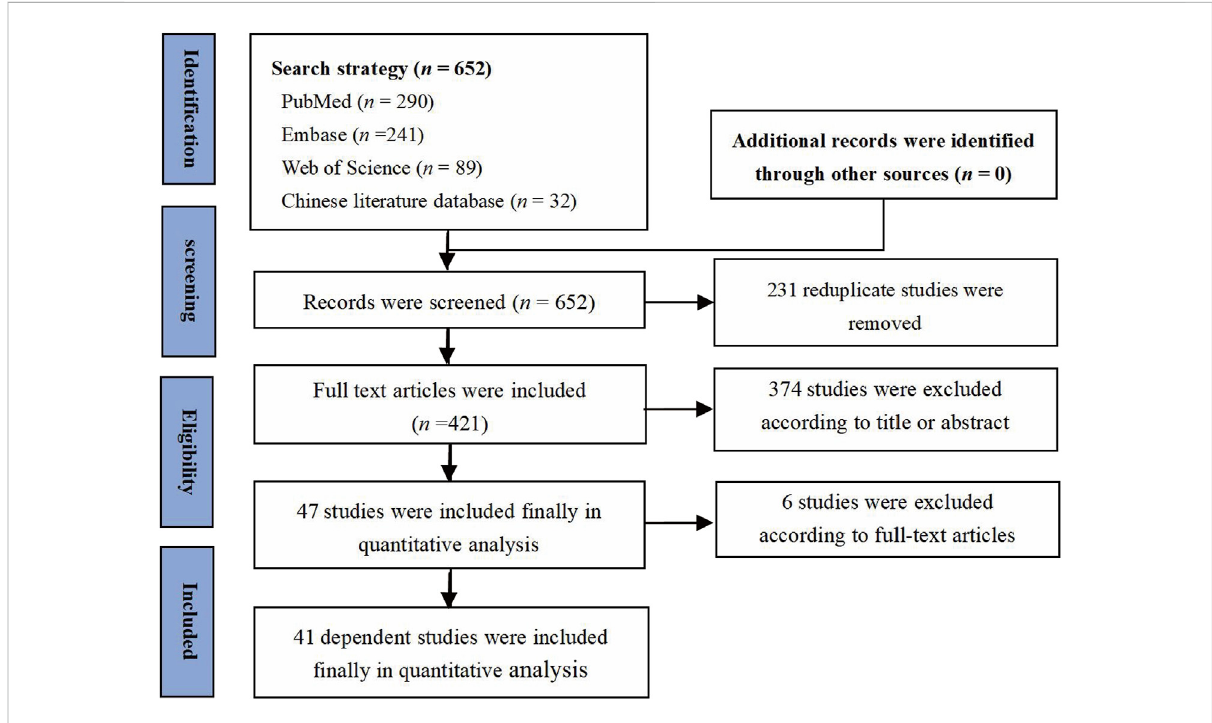
FIGURE 1 PRISMA fl ow diagram for review and selection